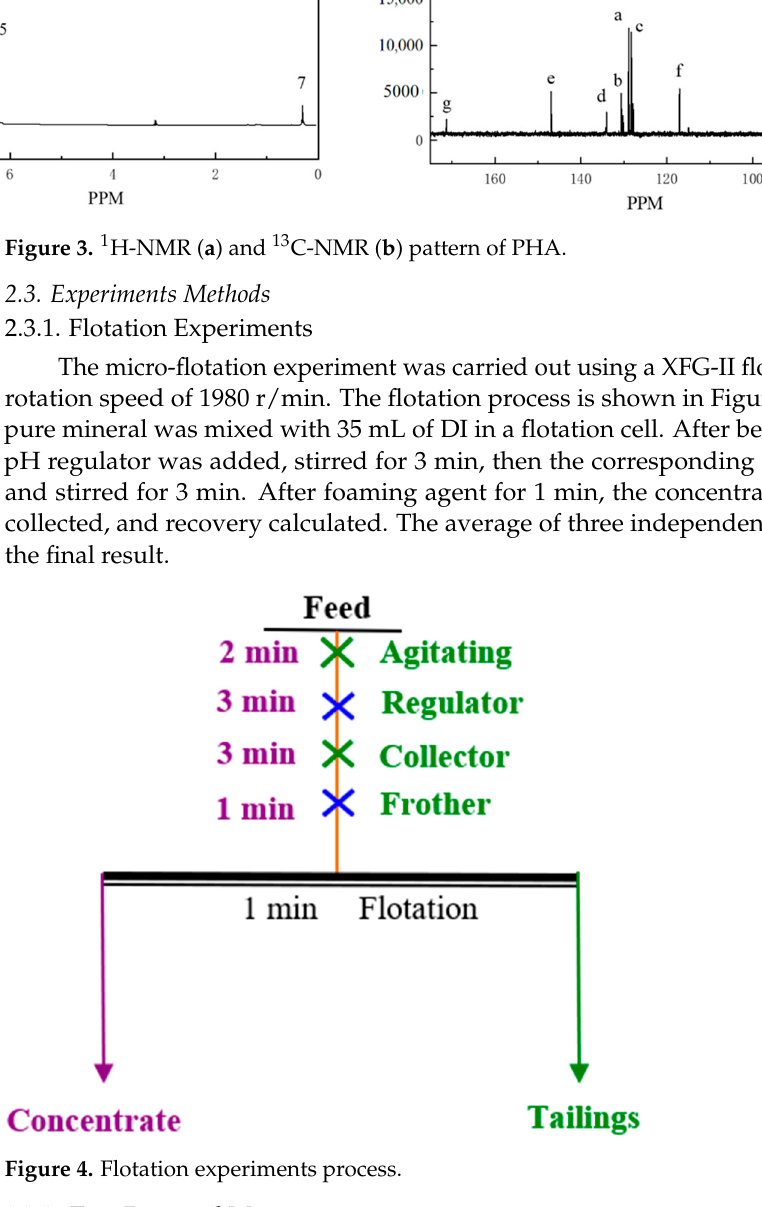
Figure 4. Flotation experiments process.